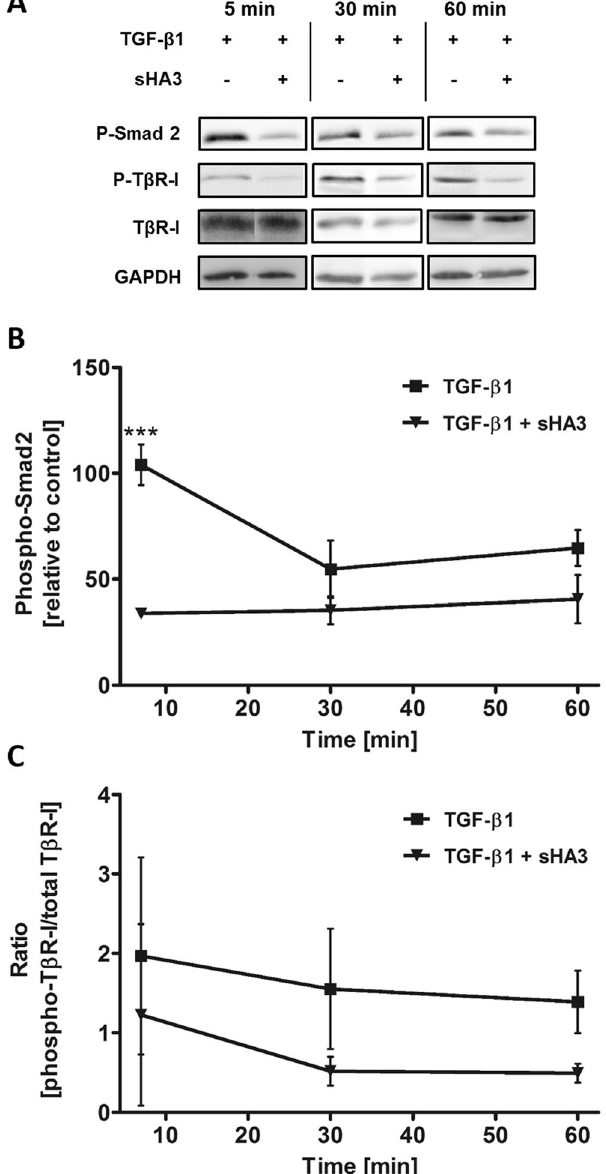
Figure 5. Influence of sHA3 on the TGF- β 1-mediated T β R-I and Smad2 phosphorylation. Hs27 fibroblast cells were stimulated with 10 ng/ml TGF- β 1 (0.4 nM) alone or pre-formed complexes of TGF- β 1 and 100 µ g/ml sHA3 (130 µ M D.U.) for the indicated time points. Cells were lysed and applied to Western Blot analyses using specific anti-phospho-Smad2, anti-phospho-T β R-I and anti-GAPDH antibodies. Membranes were reblotted afterwards with anti-T β R-I antibody. For every time point a representative blot is shown ( A ). The time course of TGF- β 1- mediated phosphorylation in the presence or absence of sHA3 is plotted for Smad2 phosphorylation ( B ) and T β R-I phosphorylation relative to unstimulated cells ( C ). Two-way ANOVA: *** p < 0.001 vs. TGF- β 1